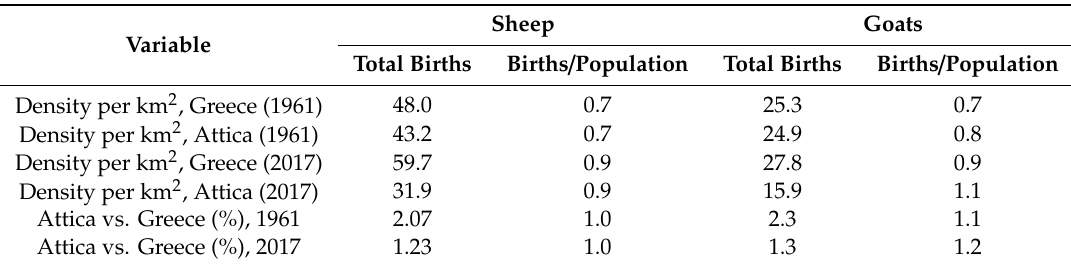
Table 4. Density of births for sheep and goats in Greece (1961 and 2017), with a focus on the Attica region. Source: own elaboration from o ffi cial statistics provided by ELSTAT (the Hellenic Statistical